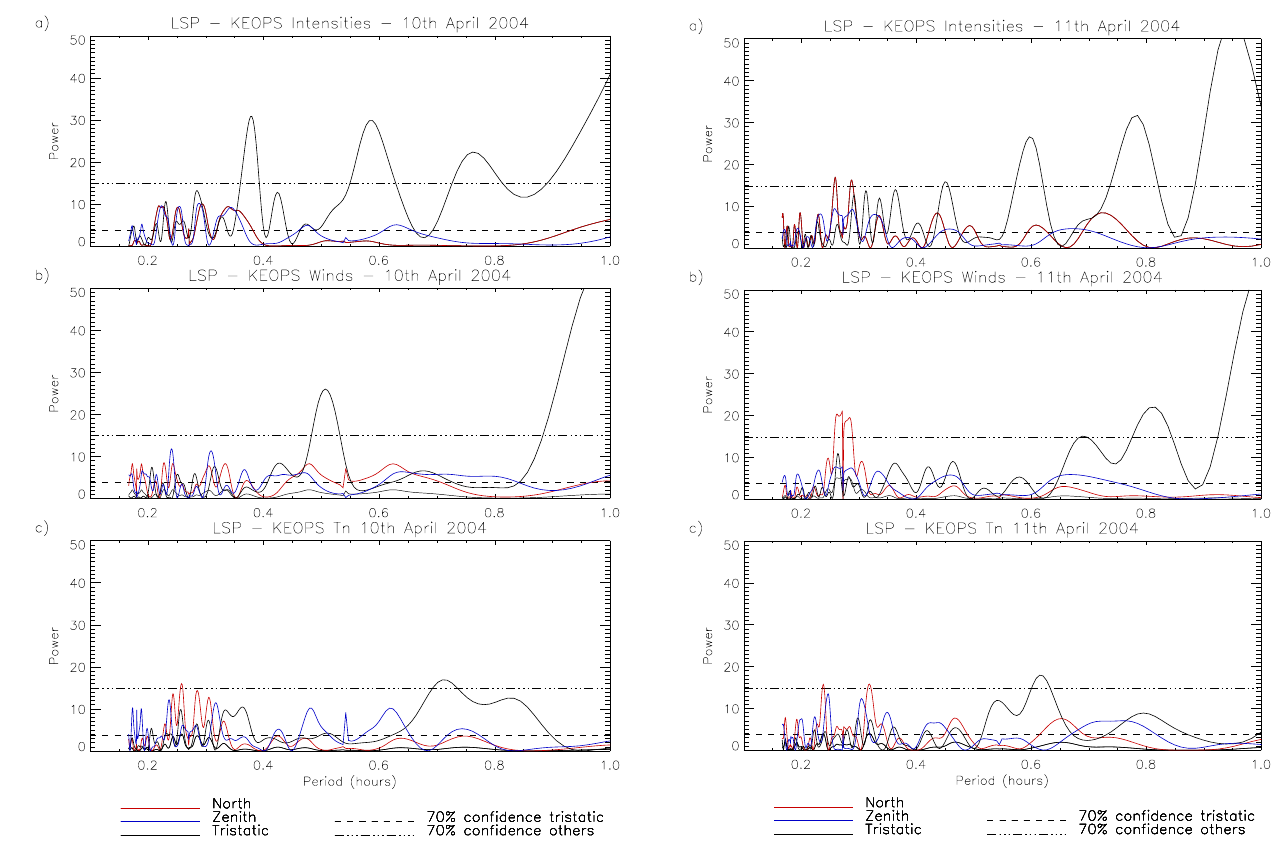
Fig. 10. Lomb-Scargle Periodogram up to periods of 1h, from KEOPS data on 10 April 2004: (a) intensities, (b) winds, and (c) temperatures. The low resolution look directions are scaled by a factor of 4.